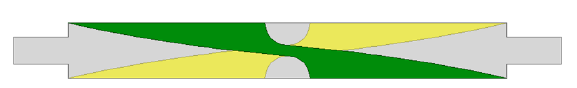
Figure 2: The card that rotates the electric field of 180°. Green trace is on the top of the substrate and the yellow one is on the